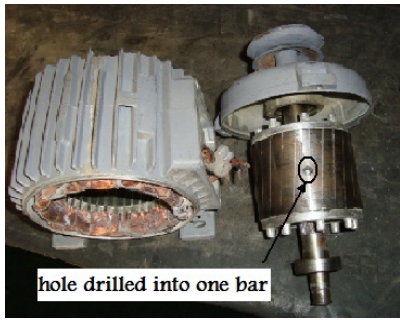
Figure 8. Seeded BRB fault.